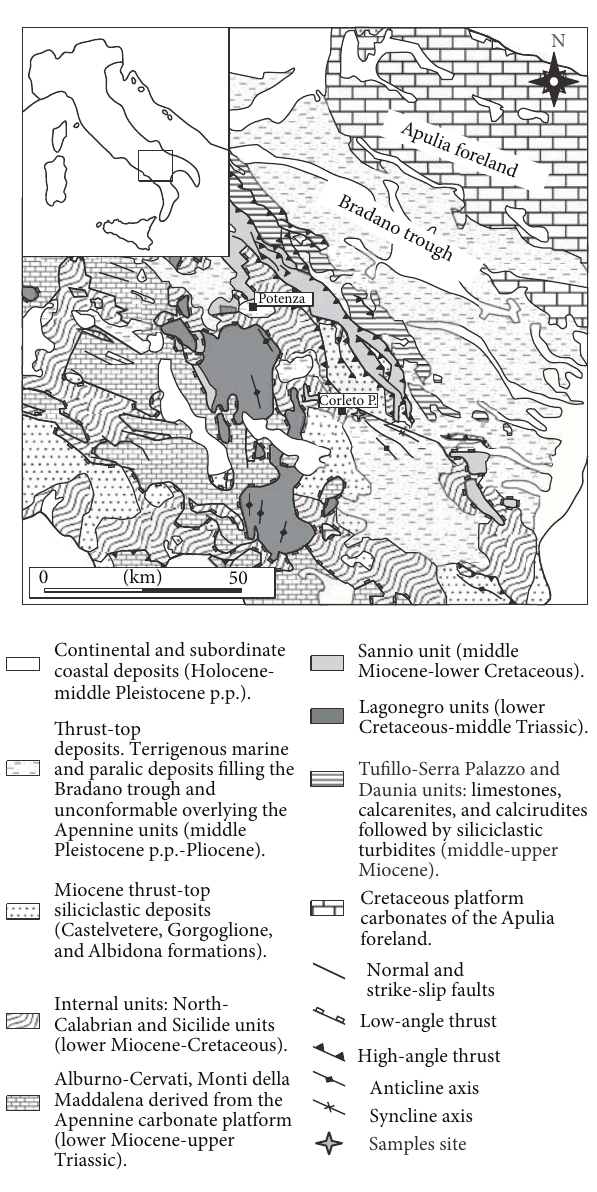
Figure 1: Geological sketch map of Southern Apennine (modified after [47]) with indication of studied